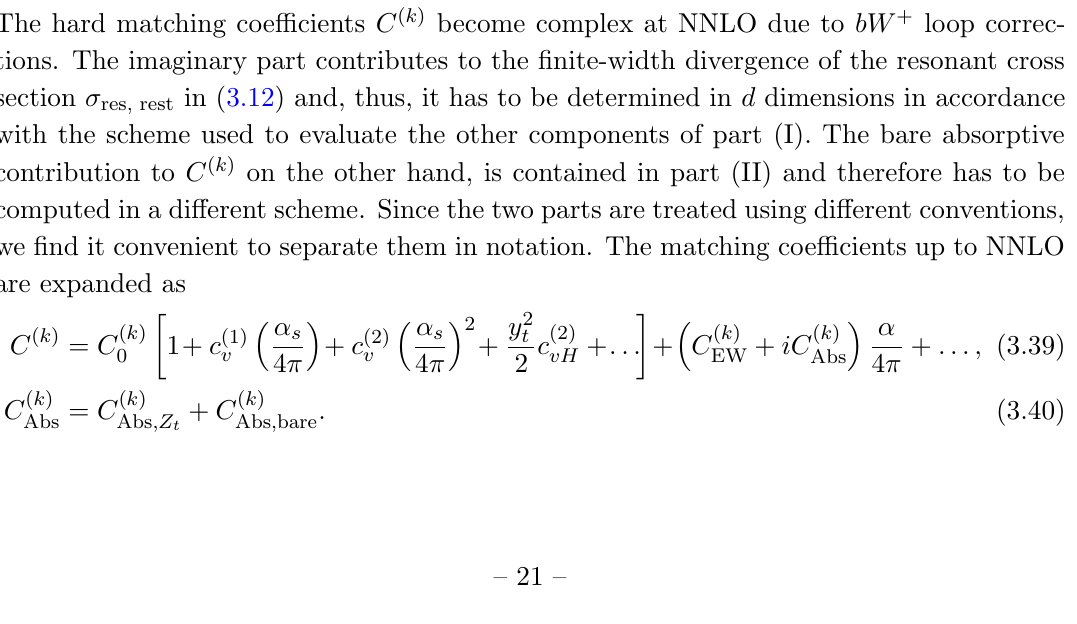
potential at order (cid:11) EW t